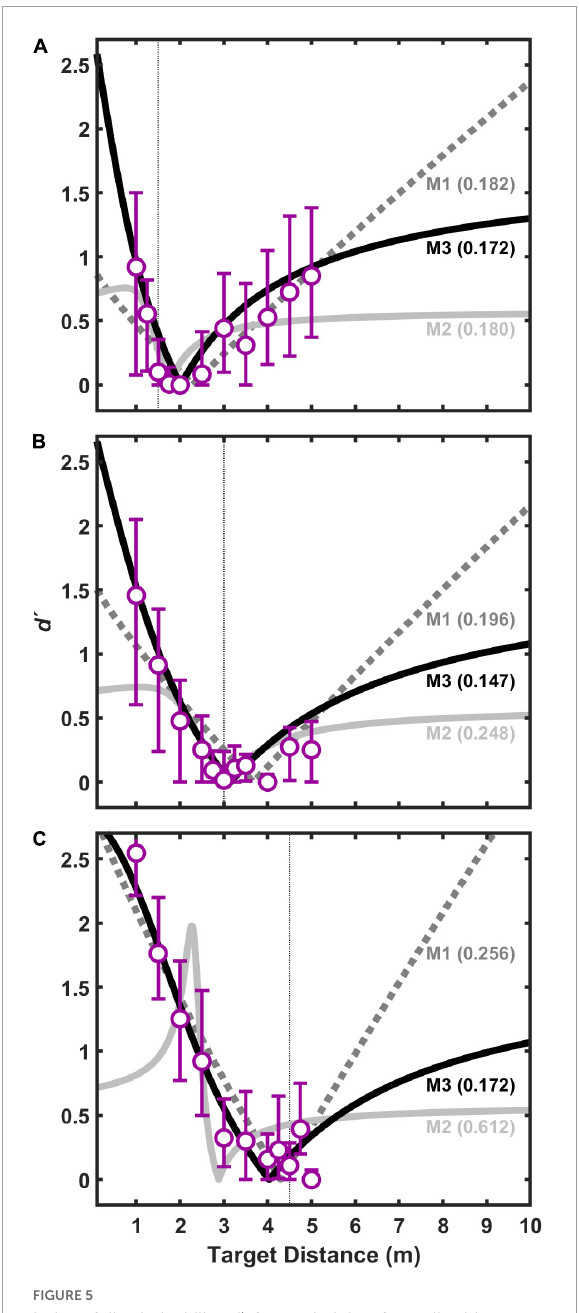
FIGURE5 Index of discriminability, d (cid:48) , for pooled data from all subjects as a function of auditory target distance for three difference visual target distances: 1.5 m (A) , 3.0 m (B) , and 4.5 m (C) . Each point is based on 330 trials (30 responses/stimulus × 11 subjects). Bars indicate 95% confidence intervals ( n = 11) estimated using a bootstrapping procedure. For each visual target distance, the data were fit with three different models, M1–M3, which are shown conceptually in Figure 2 . Each fit had two free parameters: the constant, k aud , in the auditory distance power function, and r , which is the correlation between internal estimates of auditory and visual distance (see text for details). Goodness of fit for each model was assessed using a root mean squared (RMS) error metric (shown in parentheses for each model). Smaller RMS errors indicate better